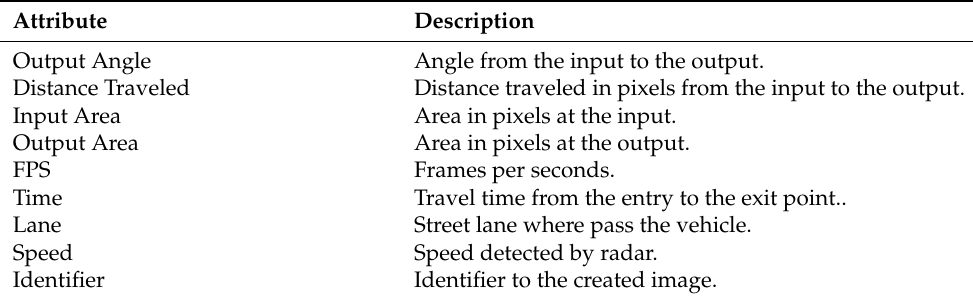
Table 2. Output attributes saved in the csv